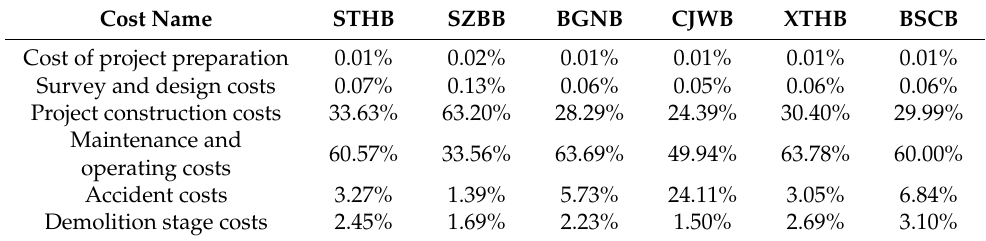
Table 8. Statistical table of the cost ratio of 6 cable-stayed bridges.